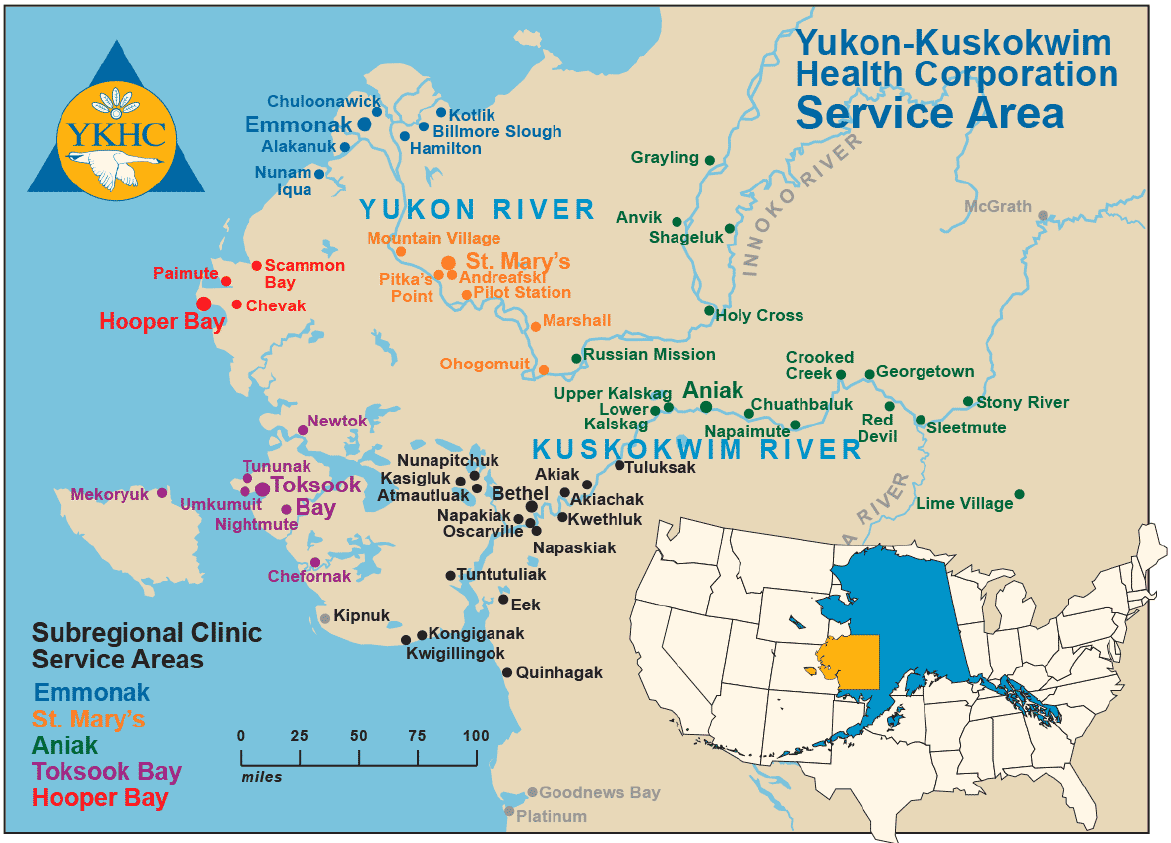
Figure 1. Yukon-Kuskokwim Health Corporation (YKHC) Service